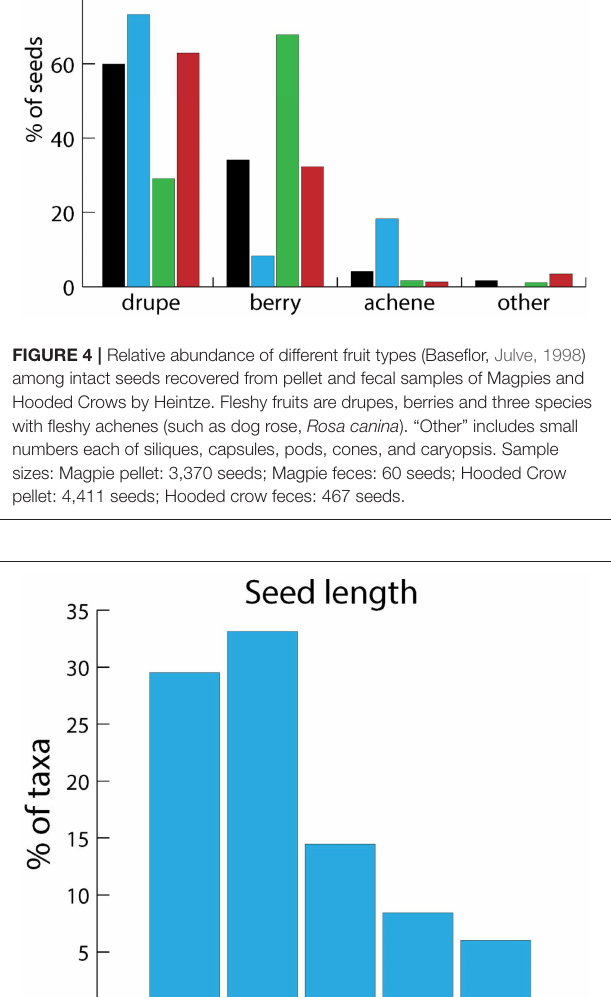
FIGURE 3 | Relative frequency of different fruit types (Baseflor, Julve, 1998) for all the plant taxa dispersed by European corvids through endozoochory, according to Heintze’s complete list ( n = 150 taxa, excluding seven species with unknown fruit types, see Table S1 for details). Fleshy fruits are drupes, berries, and seven of the 45 species with achenes (such as the fig Ficus carica ).